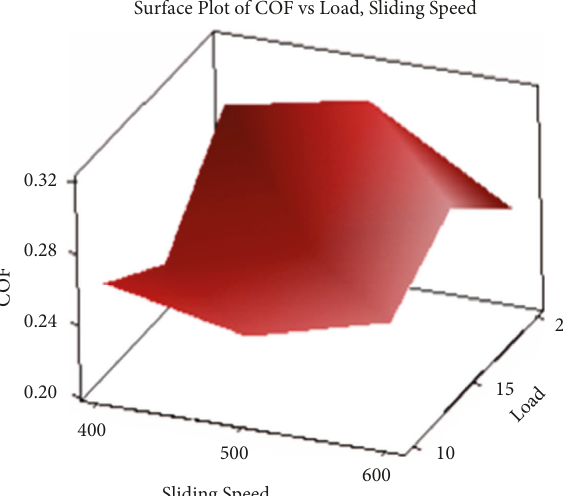
Figure 8: Surface plot graph for load % VS sliding speed to COF.